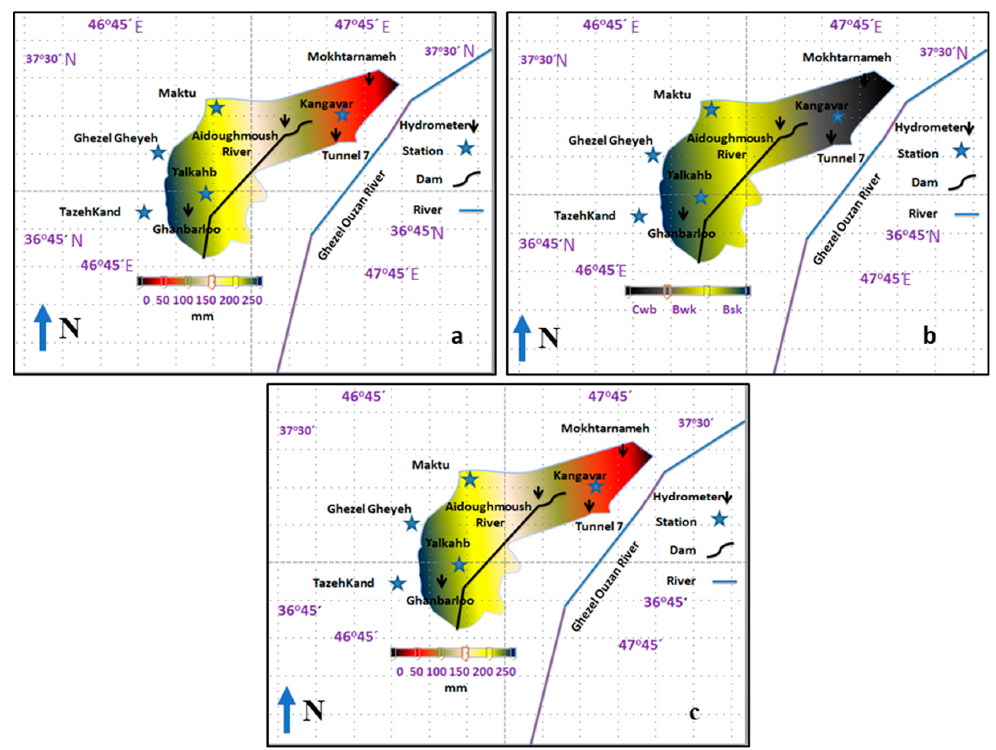
Figure 5. ( a ) The location of the case study, ( b ) The spatial of climate change and ( c ) the spatial distribution based on rainfall (mm).